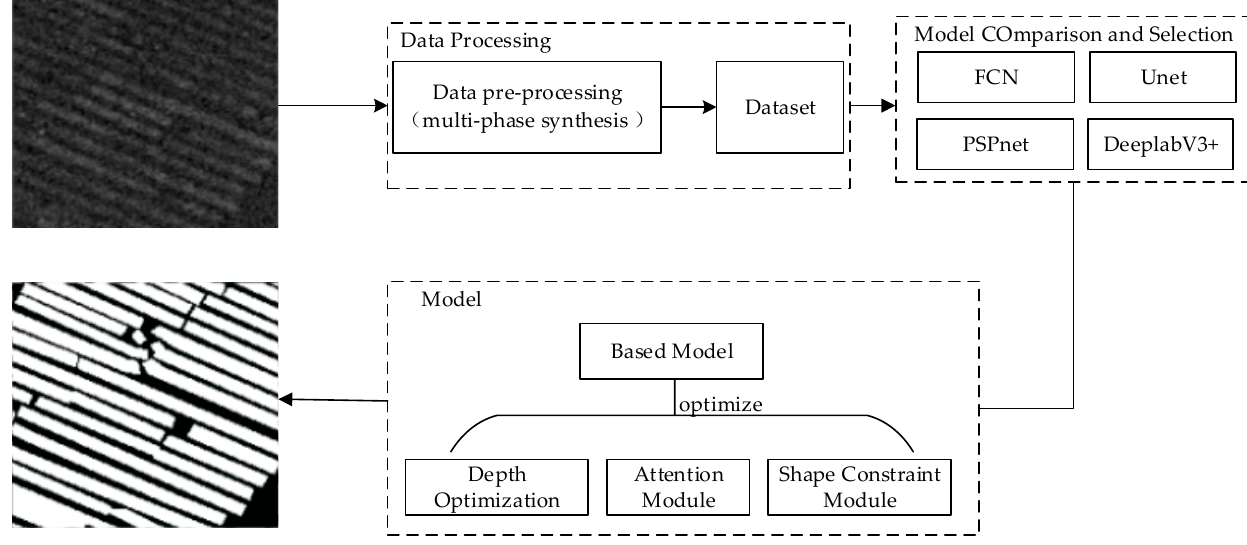
Figure 7. Overall process flow c.3.1. Multitemporal SAR Image Synthesis.